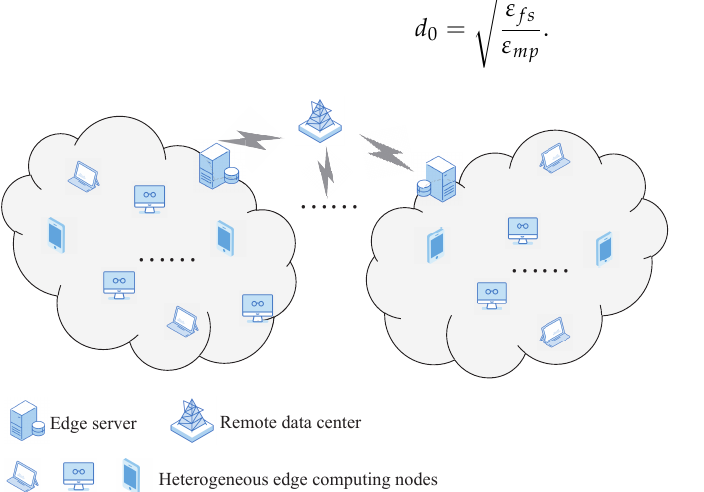
Figure 1. Heterogeneous edge computing